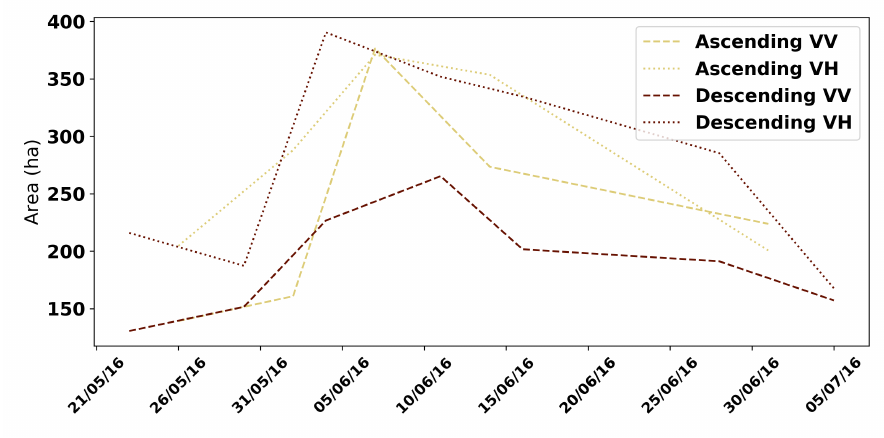
Figure 5. Water surface area evolution for the different SITS. VV = co-polarised data; VH = cross-polarised data.